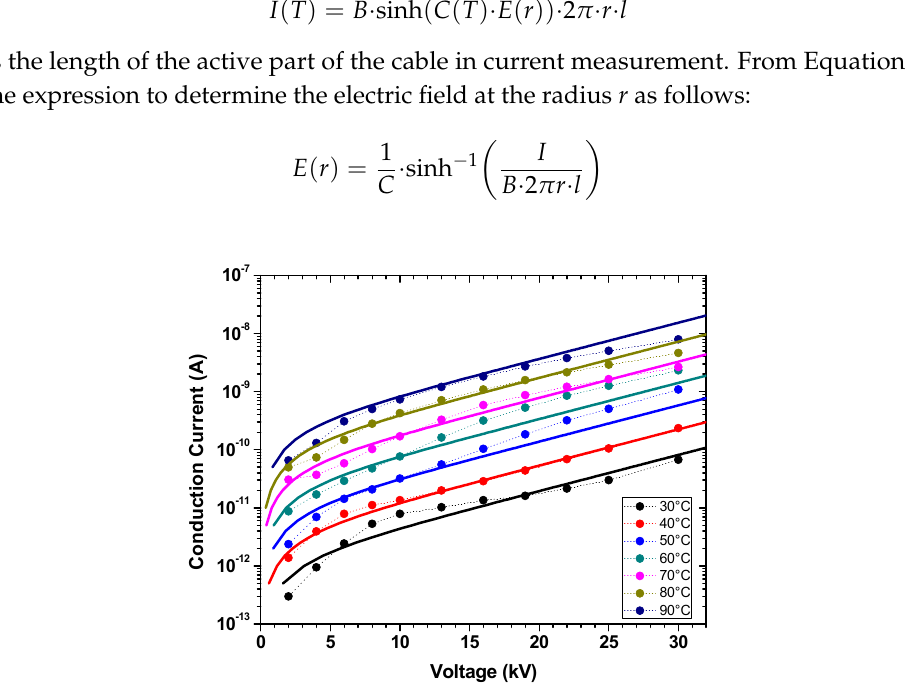
Figure 7. Conduction current results as a function of field at various temperatures. The solid lines are the results from the fit functions to the conductivity equation.